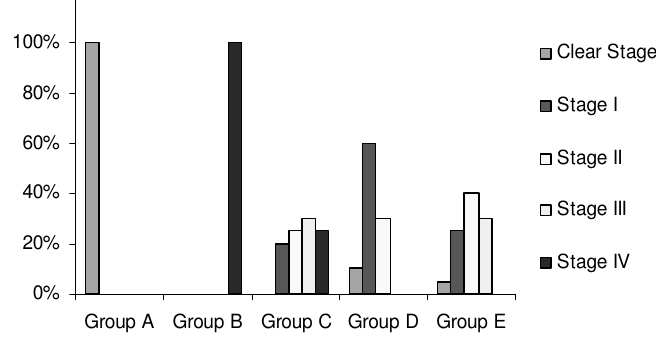
Figure 4. Graphical representation of effect of Triphala ghrita on galactose- induced cataract in rats after 30 days of the